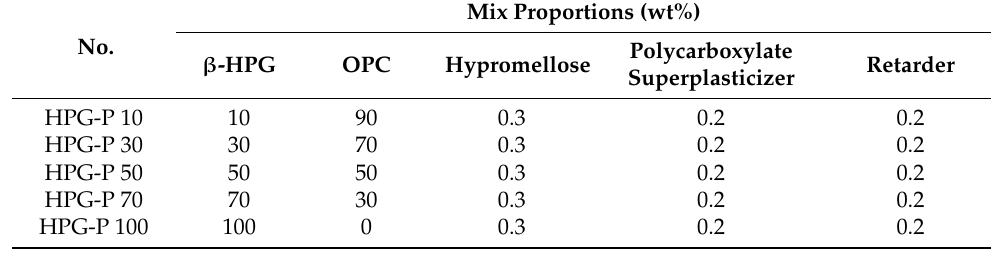
Table 4. The formulation of the HPG-E composites.